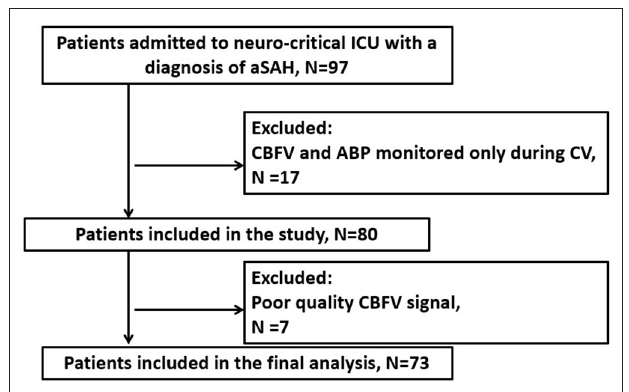
FIGURE 1 | Flow diagram of the study. ABP, arterial blood pressure; CBFV, cerebral blood flow velocity; CV, cerebral vasospasm; aSAH, aneurysmal subarachnoid